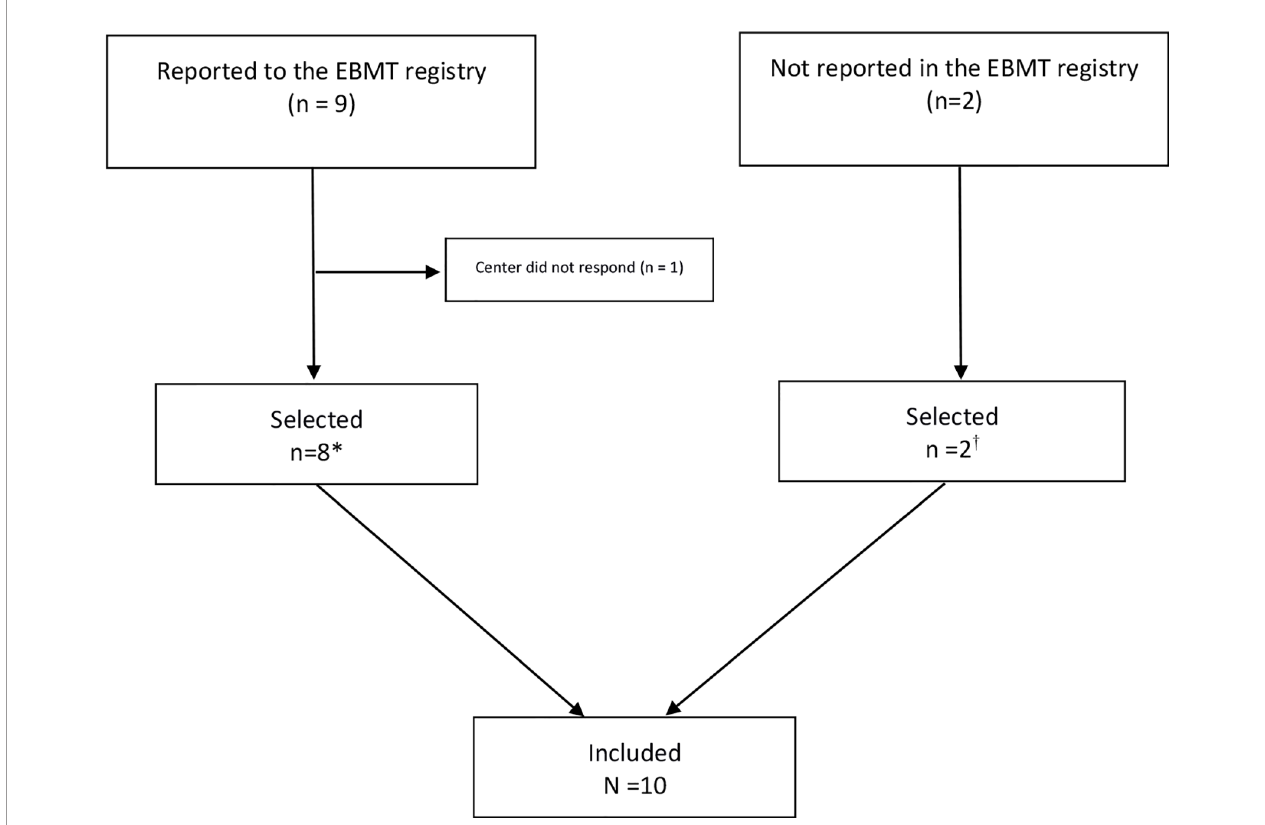
FIGURE 1 | Flow Chart on identi fi cation of patients treated with autologous hematopoietic stem cell transplantation for Behc ̧ et ’ s Disease in European Society of Blood and Marrow Transplantation (EBMT) centers (N=10). *Preliminary results of two patients with shorter follow-up were previously published (23). Long-term follow-up data are included in this manuscript. † Two cases were already published: De Cata A, Intiso D, Bernal M, et al: Prolonged Remission of Neuro-Behcet Disease following Autologous Transplantation. Int J Immunopathol Pharmacol 20:91 – 96, 2007 (center of